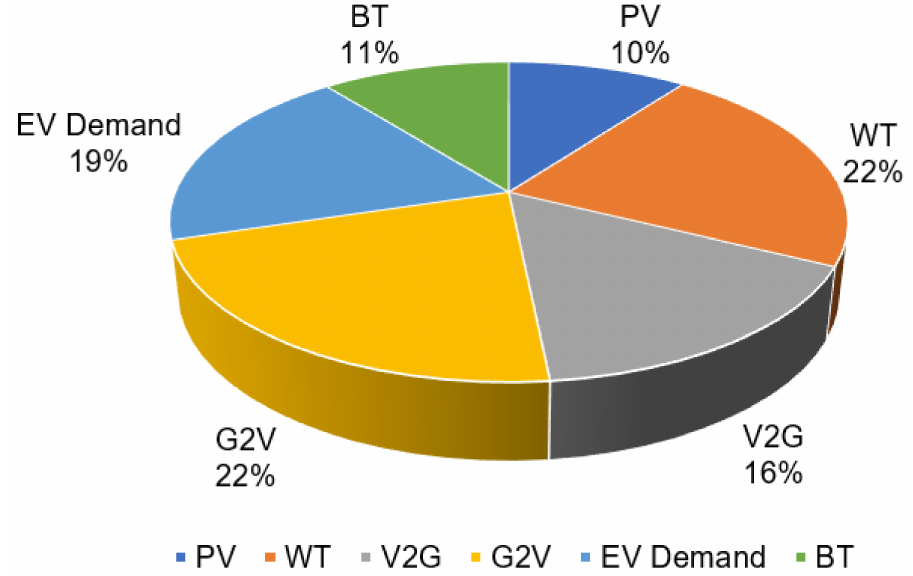
Figure 13. Configuration energy contributes.